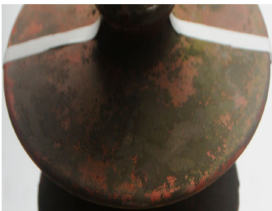
Figure 13. Schematic diagram of the insulators used in the